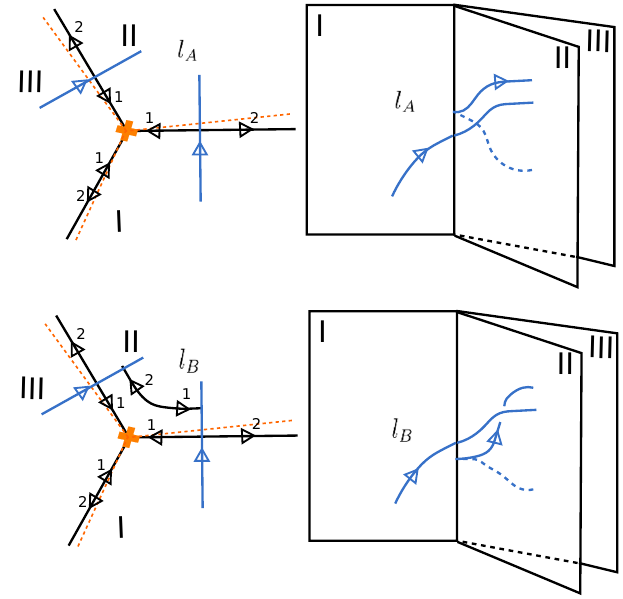
Figure 58 . The height exchange for detours.